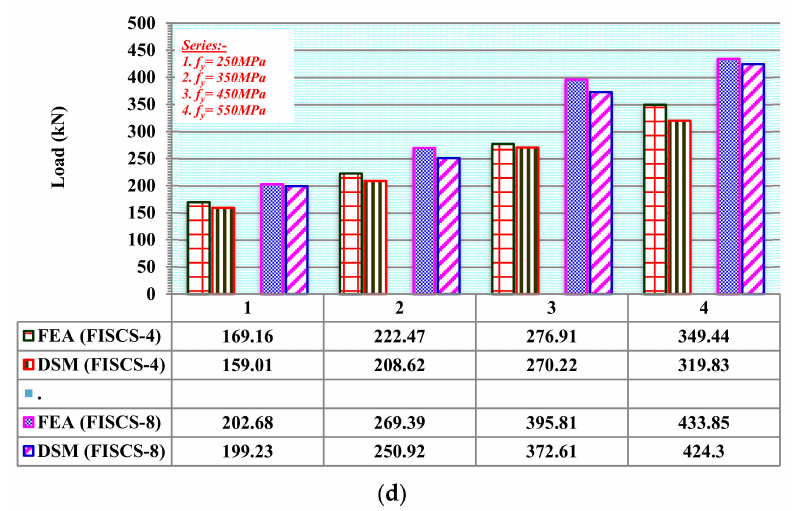
Figure 21. Column strengths from the FEA and current DSM for face-to-face intermediate stiffened channel sections-L1000 mm. ( a ) FISCS 1 & 5 (L1000 mm). ( b ) FISCS 2 & 6 (L1000 mm). ( c ) FISCS 3 &